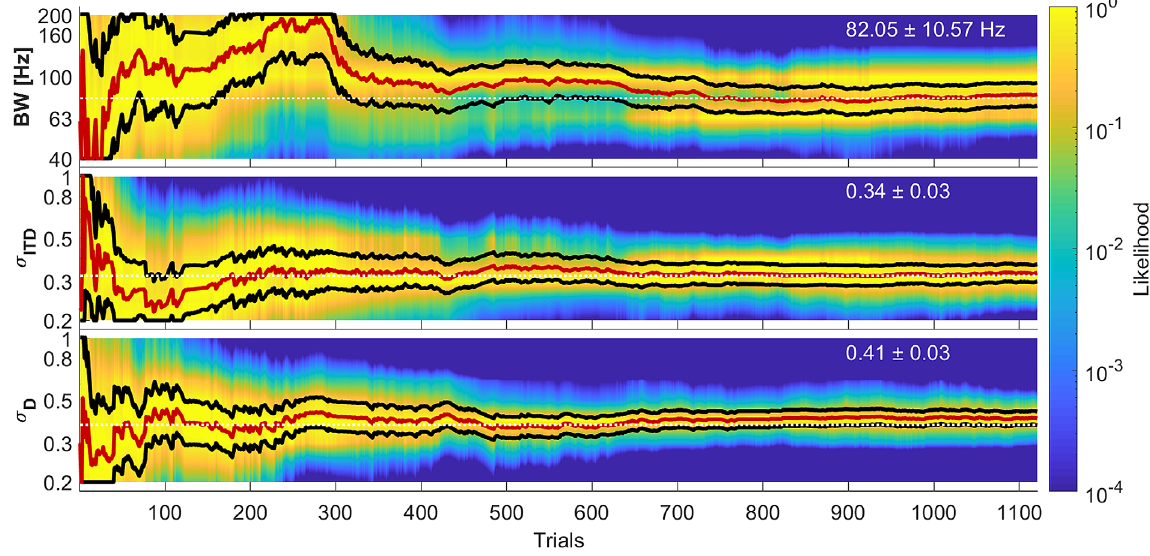
Figure 4. Example result of the model-based measurement steering with an arti fi cial test subject. In addition to the likelihood (colored), the estimated mean (red line) and the 1 (cid:2) r con fi dence intervals (black lines) are shown. The white line represents the true internal values (BW: 79 Hz, r ITD : 0.33, r D : 0.38). The last estimates of the model parameter are noted as text in the corresponding